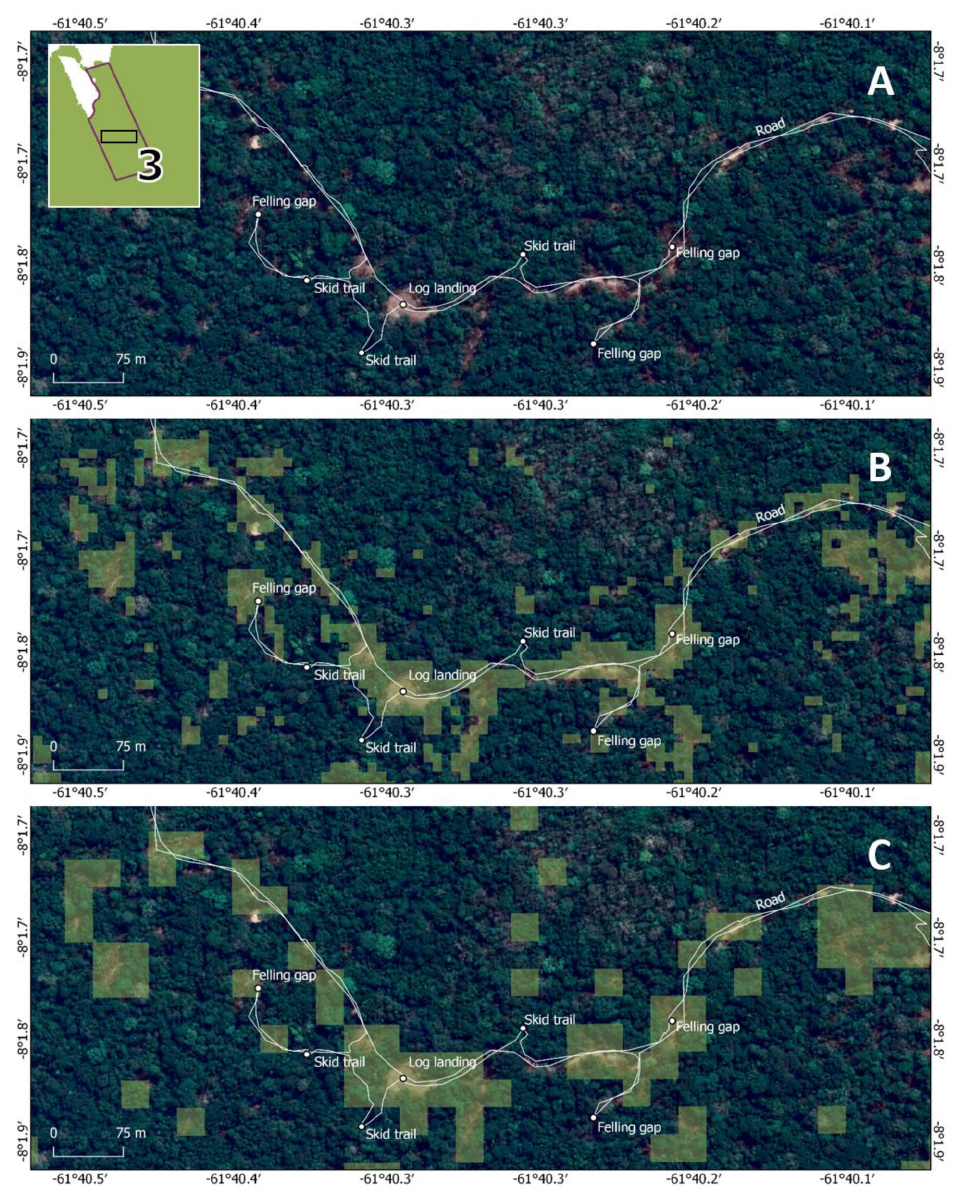
Figure 3. Detail of the sustainable forest management (SFM area nº03, showing: A ) The field data collected, B ) the areas classified as disturbed according the Sentinel-2, and C ) Landsat 8. Background image: Very-high-resolution image from 8 September 2017, available in Google Maps API and accessed via QGIS OpenLayers